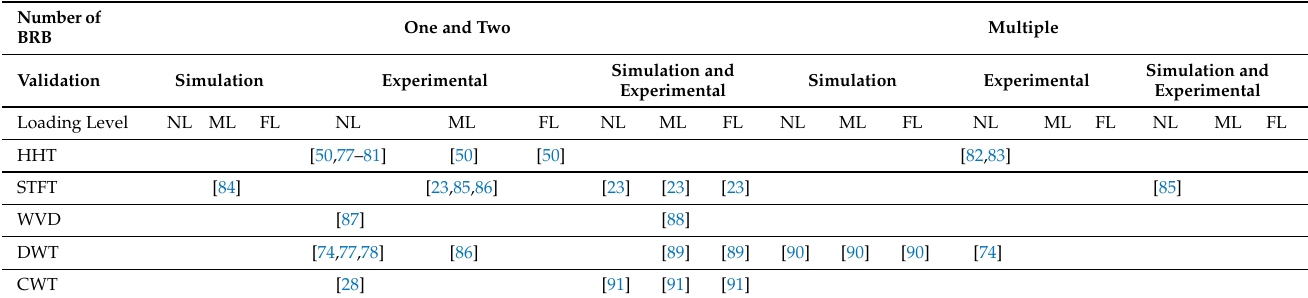
Table 4. Diagnostic classification based on MCSAs using start-up